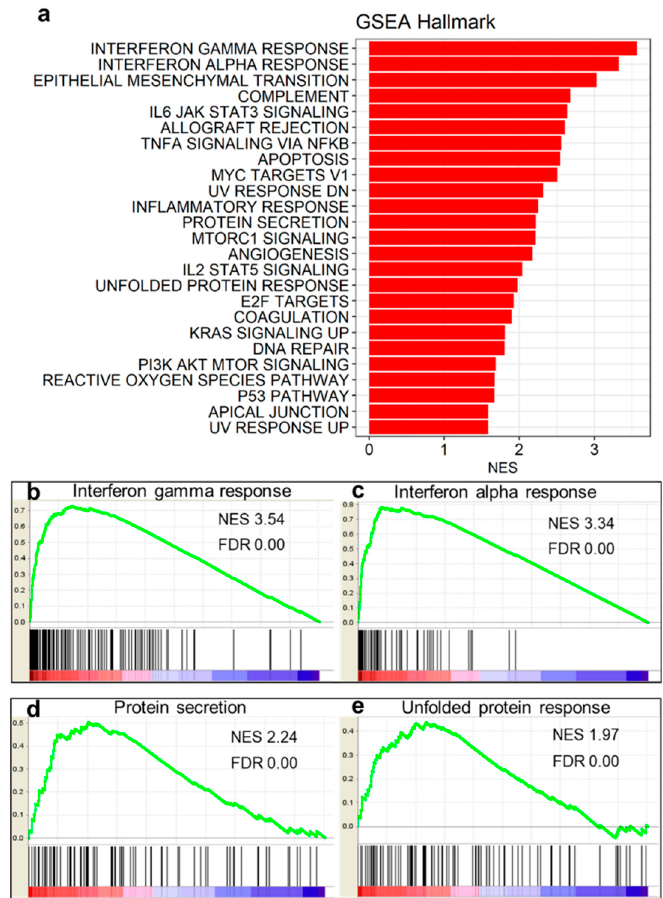
Figure 2. Gene set enrichment analysis results with hallmark gene sets. Whole genes ordered by the z-scores from the meta-analysis were used as ranked genes for analysis. ( a ) Top positively enriched biological pathways from gene set enrichment analysis (GSEA) hallmark gene sets. Normalized enrichment score (NES) is a relative value of enrichment which indicates how positive or negative the enrichment of gene set is, compared to other gene sets. GSEA plots of gene sets of intereset are displayed. ( b ) Interferon gamma response, ( c ) interferon alpha response, ( d ) protein secretion, and ( e ) unfolded protein response gene sets were positively enriched.